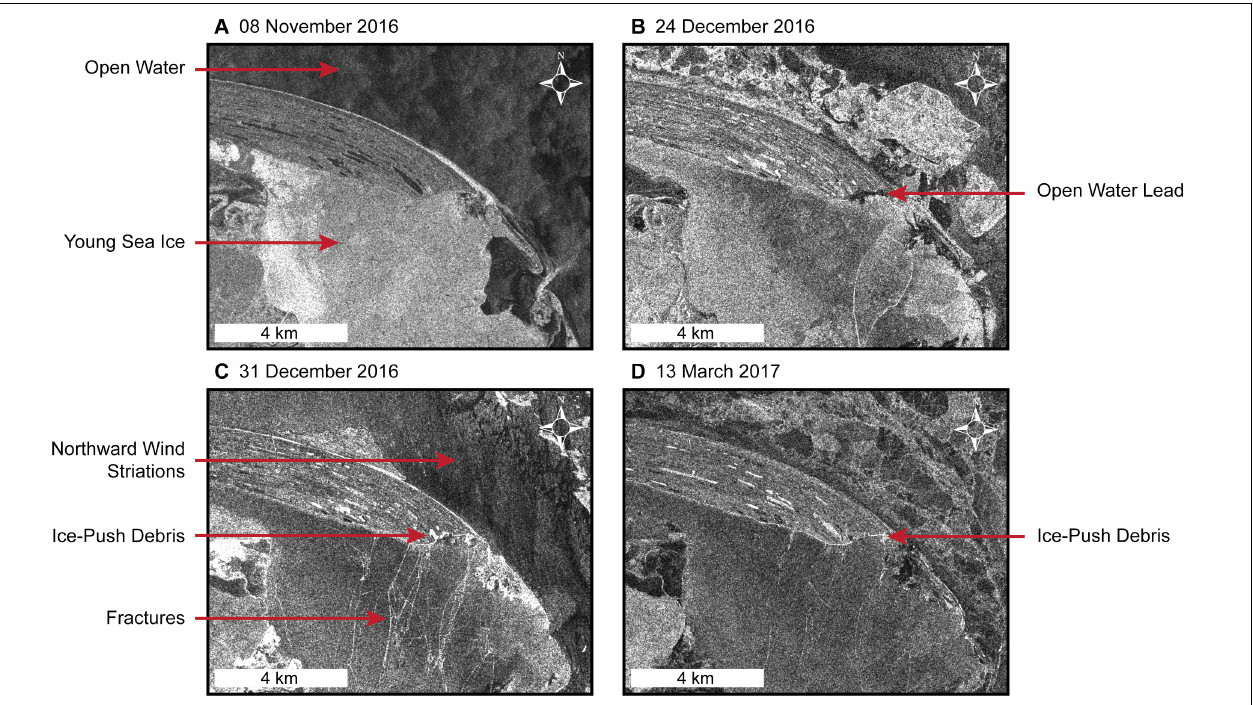
FIGURE 4 | Wide swath VV-polarized C-band synthetic aperture radar (SAR) data of the Cape Espenberg area. Backscatter intensity (unitless) is stretched over a continuous 16-bit black (low) to white (high) color gradient. A standard deviation ( n = 2) and gamma stretch (0.832) has also been applied to highlight relative differences in backscatter intensity. (A) On November 8, open water is observed along the outer coastline, while within the Espenberg Lagoon the first sea ice of the season begins to form. (B) On 24 December, an open-water lead is visible along the affected coastline on the southern tip of Cape Espenberg, as well as bright linear features in the sea ice within the lagoon. (C) On 31 December, wind striations indicate a northward wind direction, whereas ice push debris is clearly visible (white areas) in the area landward of the open-water lead shown in (B) . Large ice fractures are also visible indicating the direction of ice movement. (D) On March 13, ice push debris is still visible approximately 6 weeks after deposition.